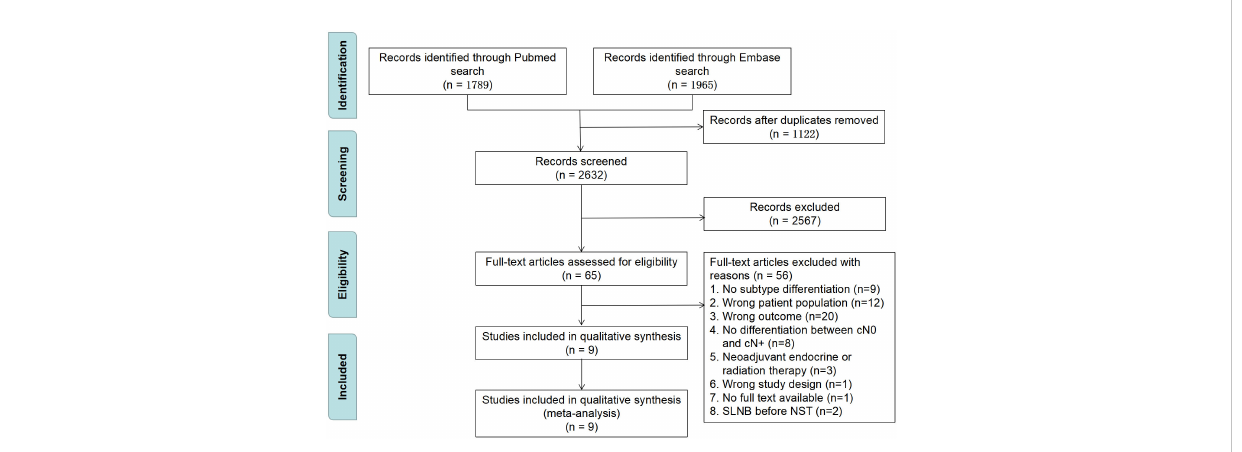
FIGURE 1 PRISMA fl ow diagram for study selection. SLNB, sentinel lymph node biopsy; NST, neoadjuvant systematic